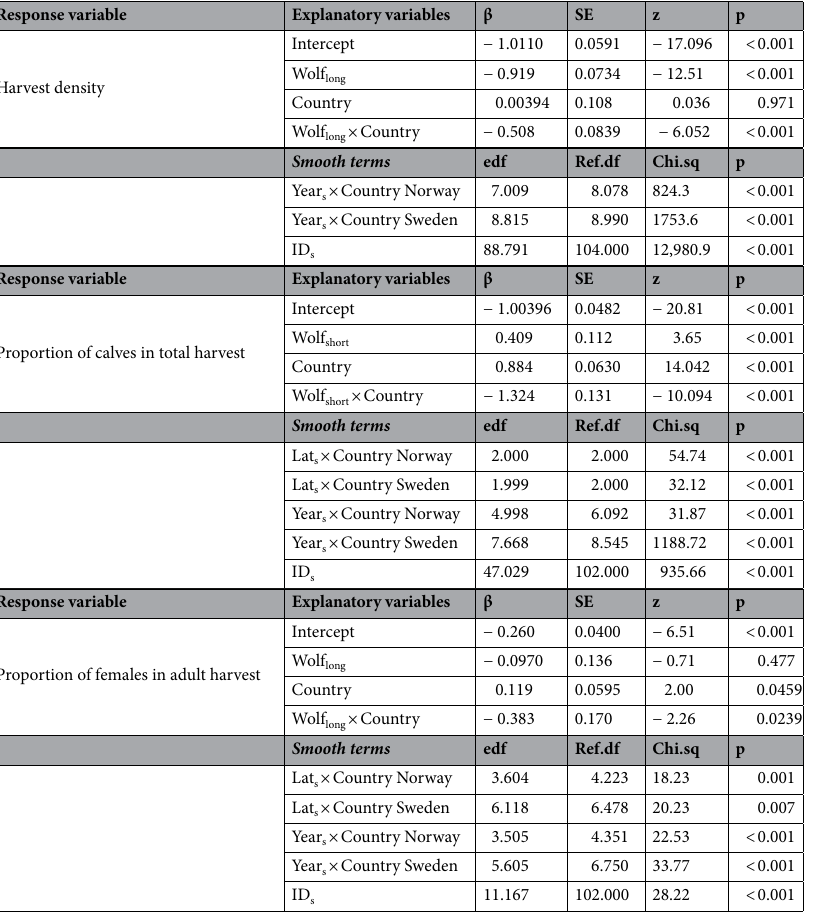
Table 2. Summary of the best generalized additive mixed models (GAMM) used to explain harvest density of moose (per km 2 ), proportion of calves in total harvest, and proportion of females in adult harvest in Sweden and Norway during 1995–2017. Explanatory variables were short- and long-term wolf index (Wolf short and Wolf long ) as linear functions, and year (Year s ) and latitude (Lat s ) as smooth functions. Country (Norway, Sweden) was included either individually or in interaction with the other variables, with “Norway” as the reference level. The management unit ID was used as a smooth random variable (ID s